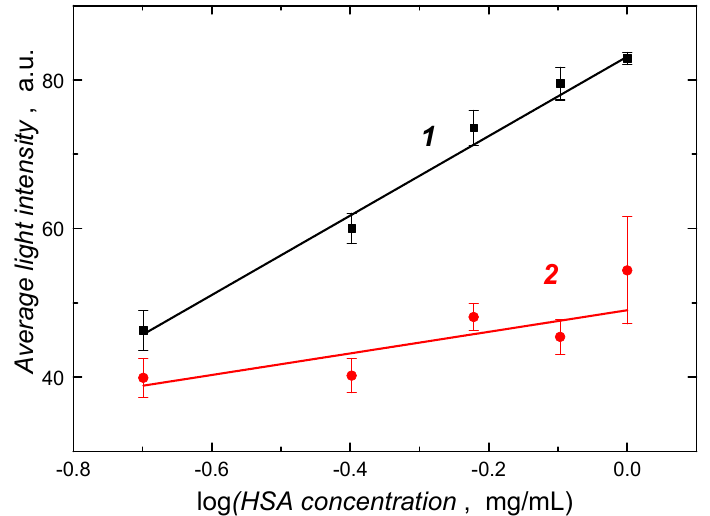
Figure 5. The calibration plots for human serum albumin (HSA) analyte in 0.1 M PBS (pH = 7.4) constructed using 1658 (liquid crystal eutectic)-containing optical cells with (1) MIP-HSA and (2) NIP film-coated semitransparent Au film-coated glass slides.